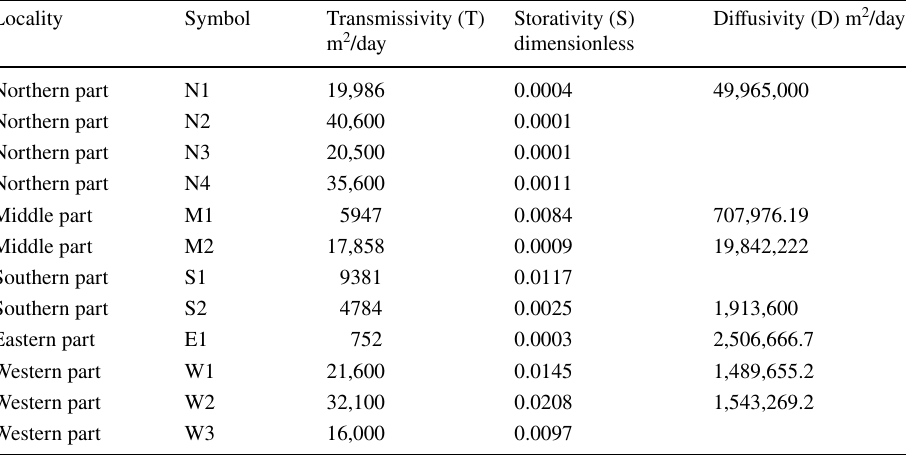
Fig. 2 Water table contour map of the selected groundwater wells during Dec 1992. (After Gad